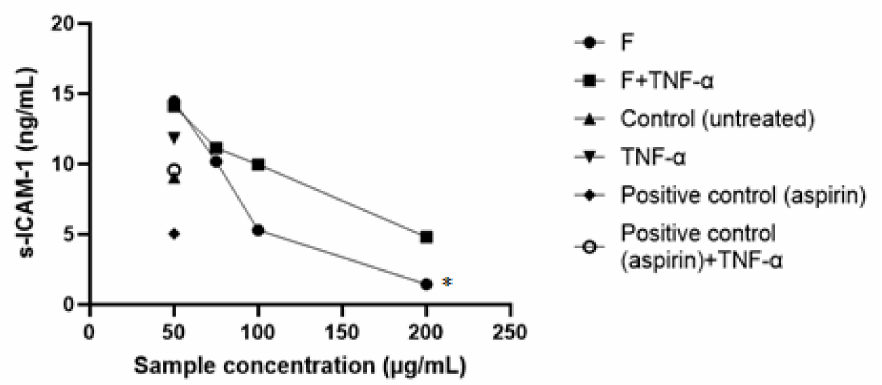
Figure 7. ICAM-1 expression in HUVECs stimulated with TNF- α . Each point indicates the mean ± SD of three measurements. * p < 0.05 significantly different compared to unstimulated